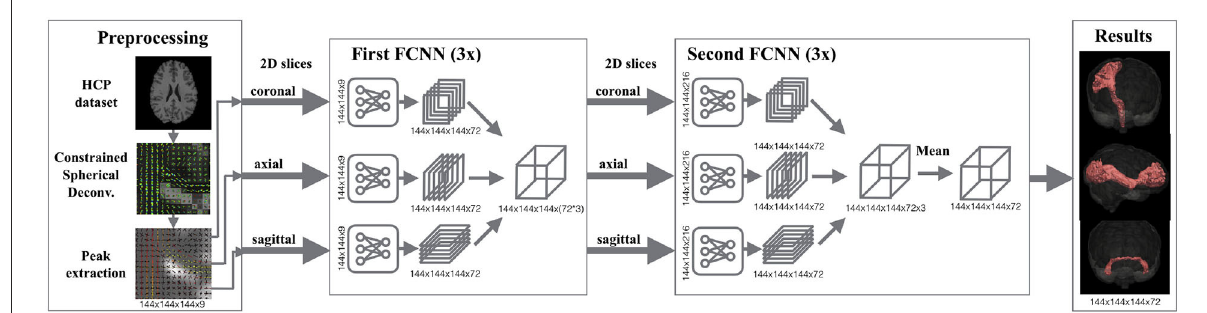
FIGURE1 Segmentation pipeline of TractSeg. Left: The dMRI data is pre-processed for extracting the peaks of the fiber orientation distribution functions per voxel. These peaks are used as the input of the neural network. Middle: 2D U-Net-like fully convolutional neural networks (FCNNs) are trained to segment fiber bundles. Three networks are trained per axis (coronal, axial, sagittal) in two stages. While the goal in the first stage is to segment the fiber bundles using 2D information, the second stage aims at learning the best combination of the three intermediate results to generate the final segmentation. Right: Segmentation masks of 72 fiber bundles are generated. Figure reproduced from Wasserthal et al. (29), license CC BY